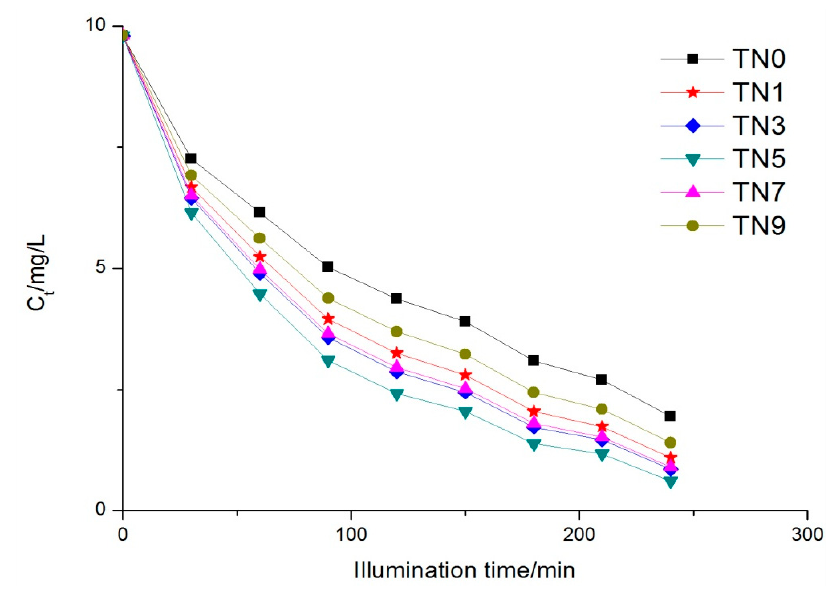
Figure 5. Reaction kinetics trend under UV light.